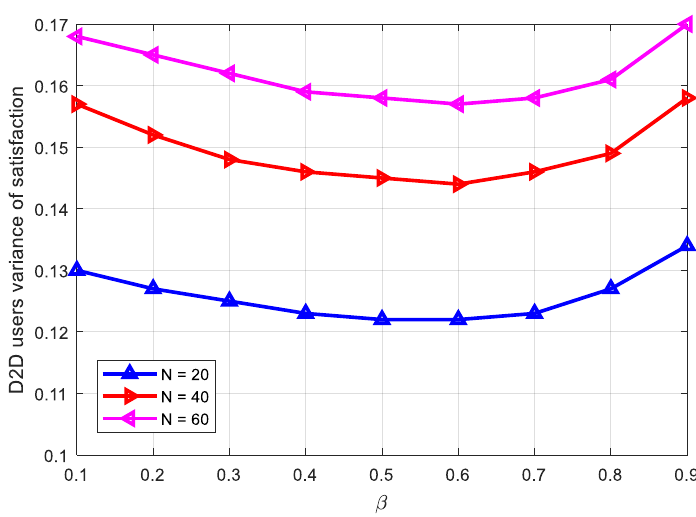
Figure 5. Comparison of the variance of satisfaction of D2D users under different values of 𝛽 .